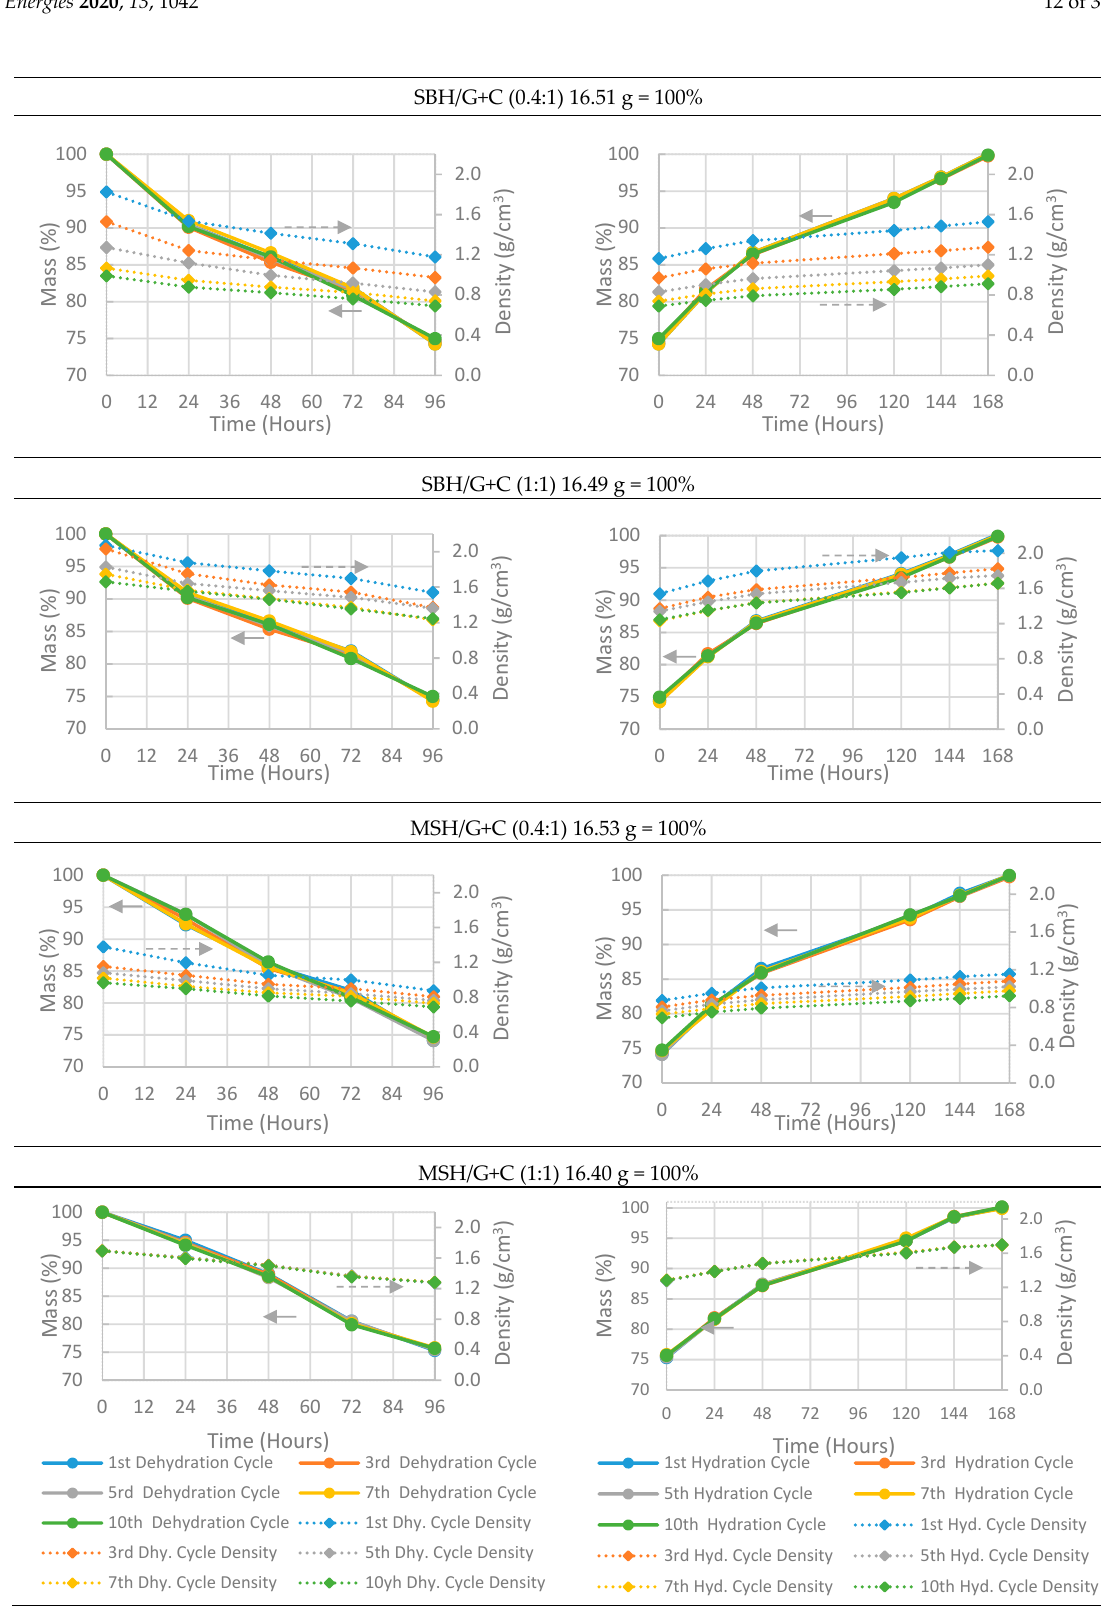
Figure 13. Hydration and dehydration charts of pellets with prepared under a 5.2 kN ⋅ mm − 2 compression ratio. Each pellet has a 75% salt hydrate mass ratio. Left column: dehydration charts; right column: hydration charts. All the mass measurements have an accuracy of ± 0.001 g (< 0.5%).